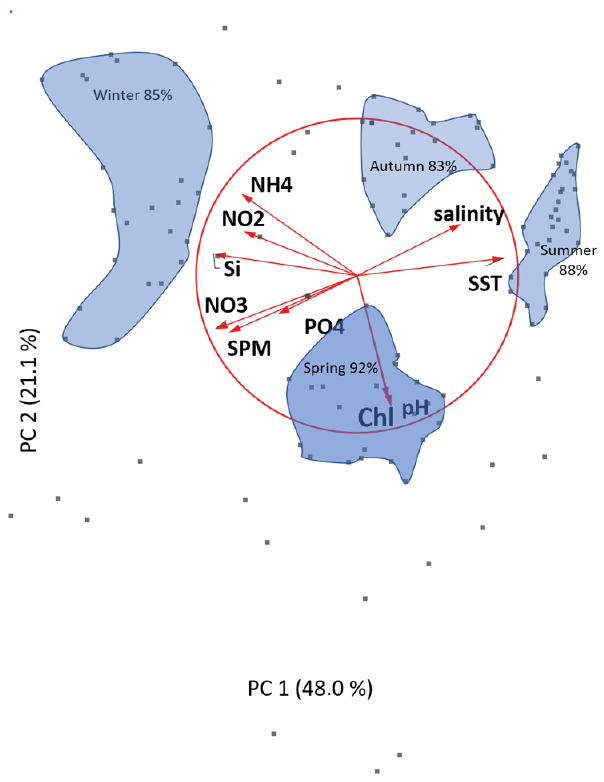
Figure 4. PCA correlation monoplot of the first two principal com- ponents. Sylt Roads LTER time series with physical and hydro- chemical parameters and seasonal averages are shown. Areas cov- ering > 83% of the data points are displayed for each